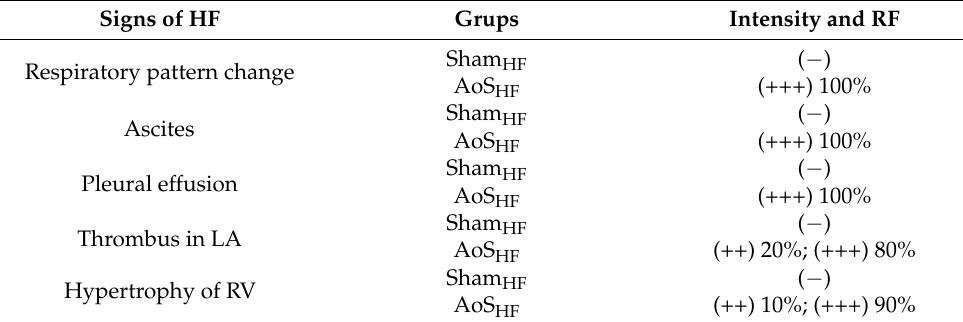
Table 1. Clinical and pathological data of heart failure (HF). Signs of HF Grups Intensity and RF Sham HF ( − ) Respiratory pattern change